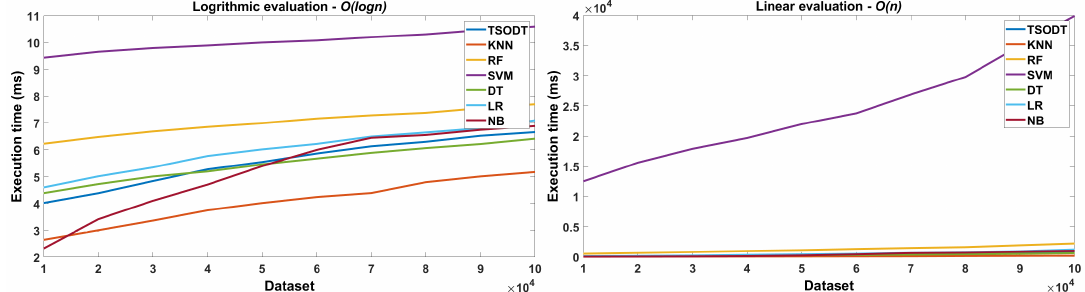
Figure 7. Performance comparison different classifiers for logarithmic and linear Big O.